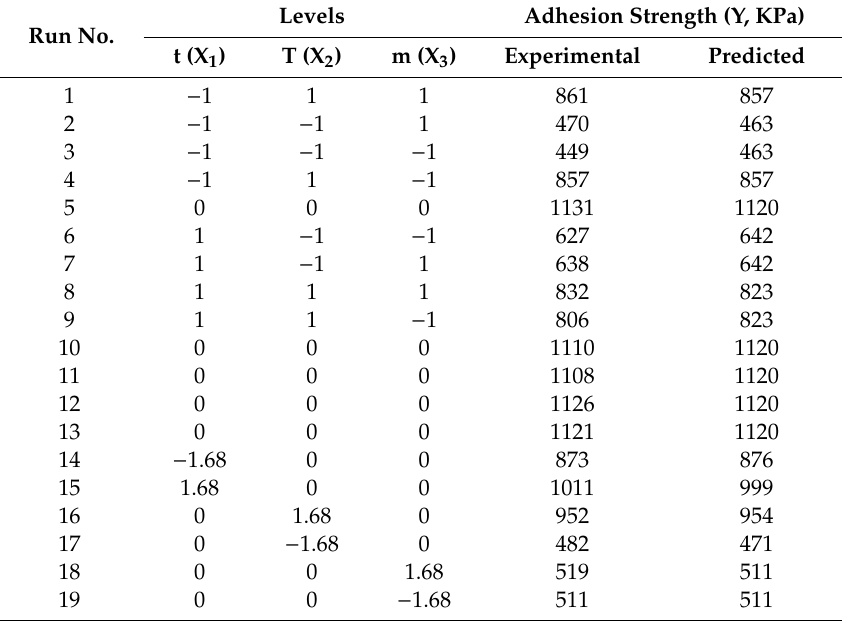
Table 2. The experimental design in terms of coded values and the results. Run